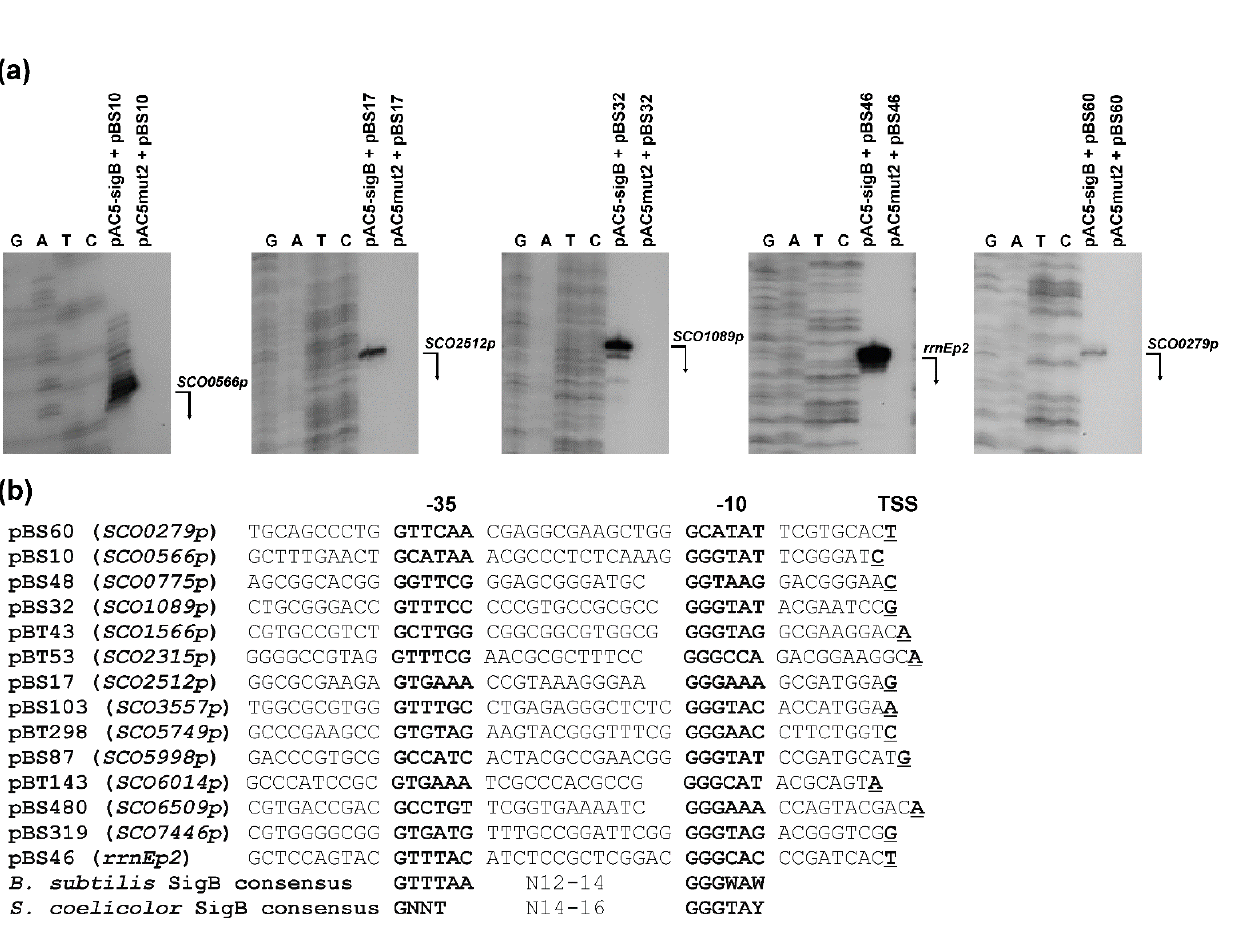
Figure 3. Representative plasmids containing SigB-dependent promoters from S. coelicolor A3(2). ( a ) Examples of high- resolution S1-nuclease mapping of transcription start site (TSS) of SigB-dependent promoters in the E. coli two-plasmid system. Isolation of RNA and S1-nuclease mapping are described in Material and Methods. The 5 (cid:48) -labeled DNA probes were hybridized with 40 µ g of RNA isolated from the stationary phase cultures of E. coli containing indicated plasmids and treated with 120 U of S1-nuclease. The RNA-protected DNA fragments were analyzed on DNA sequencing gels together with G, G + A (lane A), T + C (lane T), C sequencing ladders derived from the end-labelled DNA fragments [46]. The bent arrows indicate the positions of the protected fragments. Before assigning the TSS, 1.5 nt was subtracted from the length of the protected DNA fragment to account for the difference in the 3 (cid:48) ends resulting from S-nuclease digestion and chemical sequencing reactions. ( b ) Comparison of identified SigB-dependent promoters located in representative plasmids with the consensus sequence of promoters recognized by B. subtilis SigB [44] and S. coelicolor A3(2) SigB [45]. The promoter names are derived from the annotated SCO genes from S. coelicolor A3(2) (GenBank Acc. No. AL645882), which are under the control of the promoters. The proposed -35 and -10 promoter regions are in bold. The TSS is in bold and underlined. W = A/T, Y =